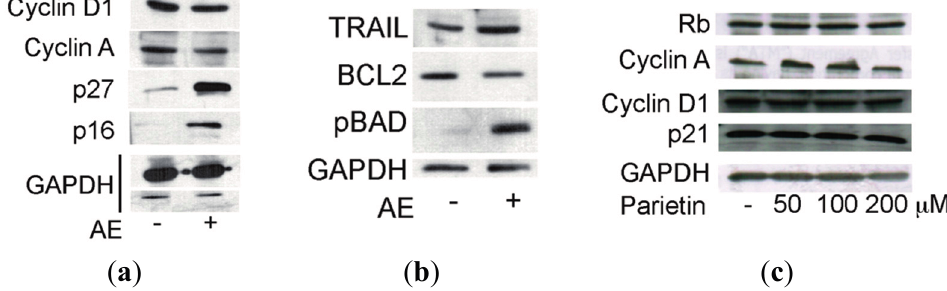
Figure 4. Western blot analysis of molecular effects of Xanthoria parietina extract (AE) and parietin in breast cancer cells after 48 h of treatment at the indicated